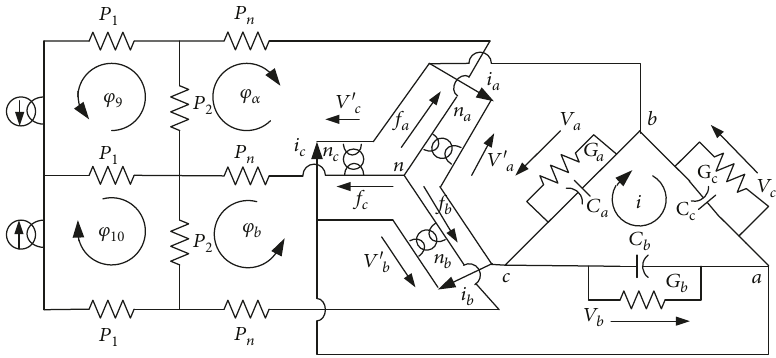
Figure 1: The equivalent circuit of the single- to three-phase converter